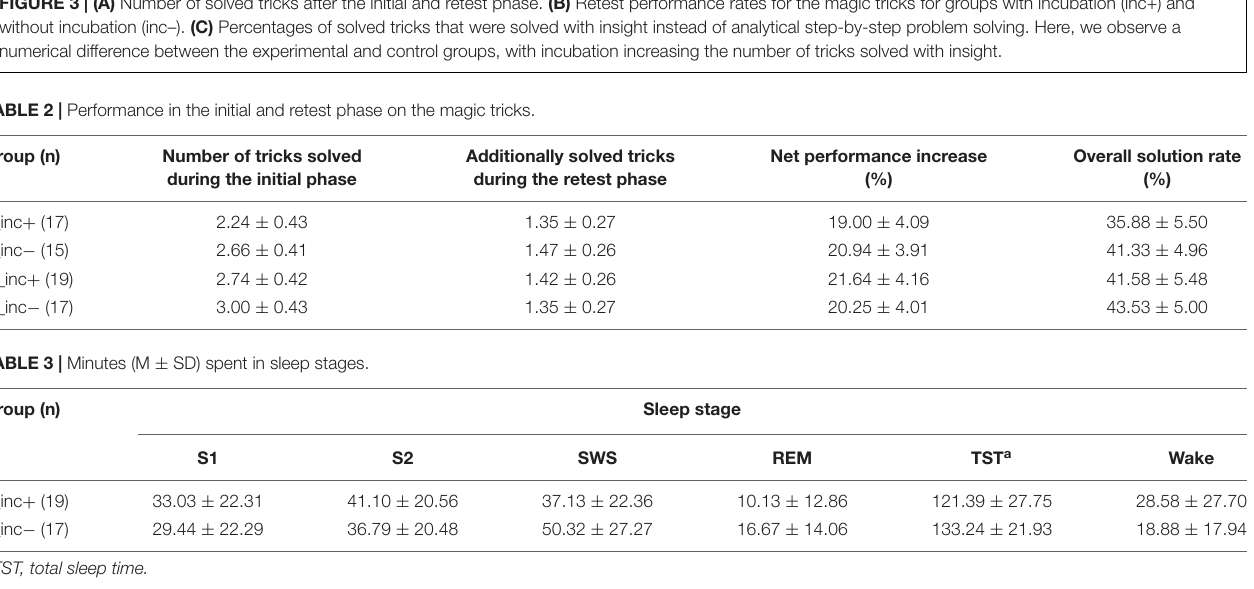
TABLE 4 | Correlations between memory performance measures and specific sleep stages in s_inc + . S1 S2 Wake Retest solution rates of the magic tricks